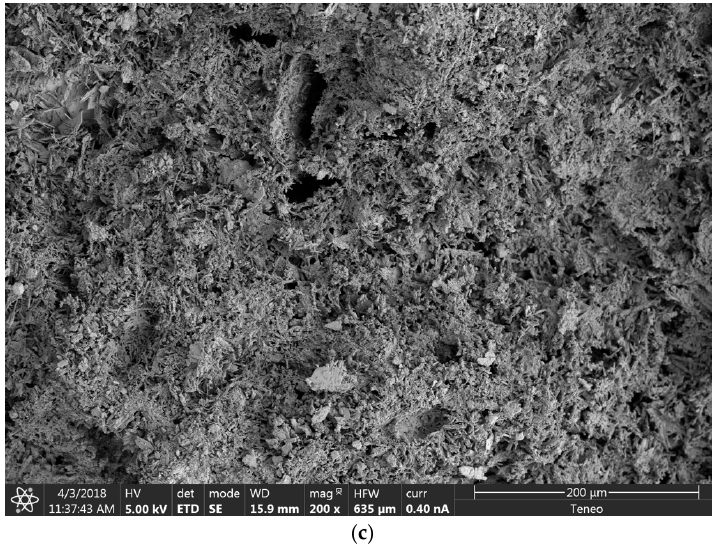
Figure 13. Reference SEM Analysis. ( a ) Five cycles; ( b ) 10 cycles; ( c ) 15 cycles.